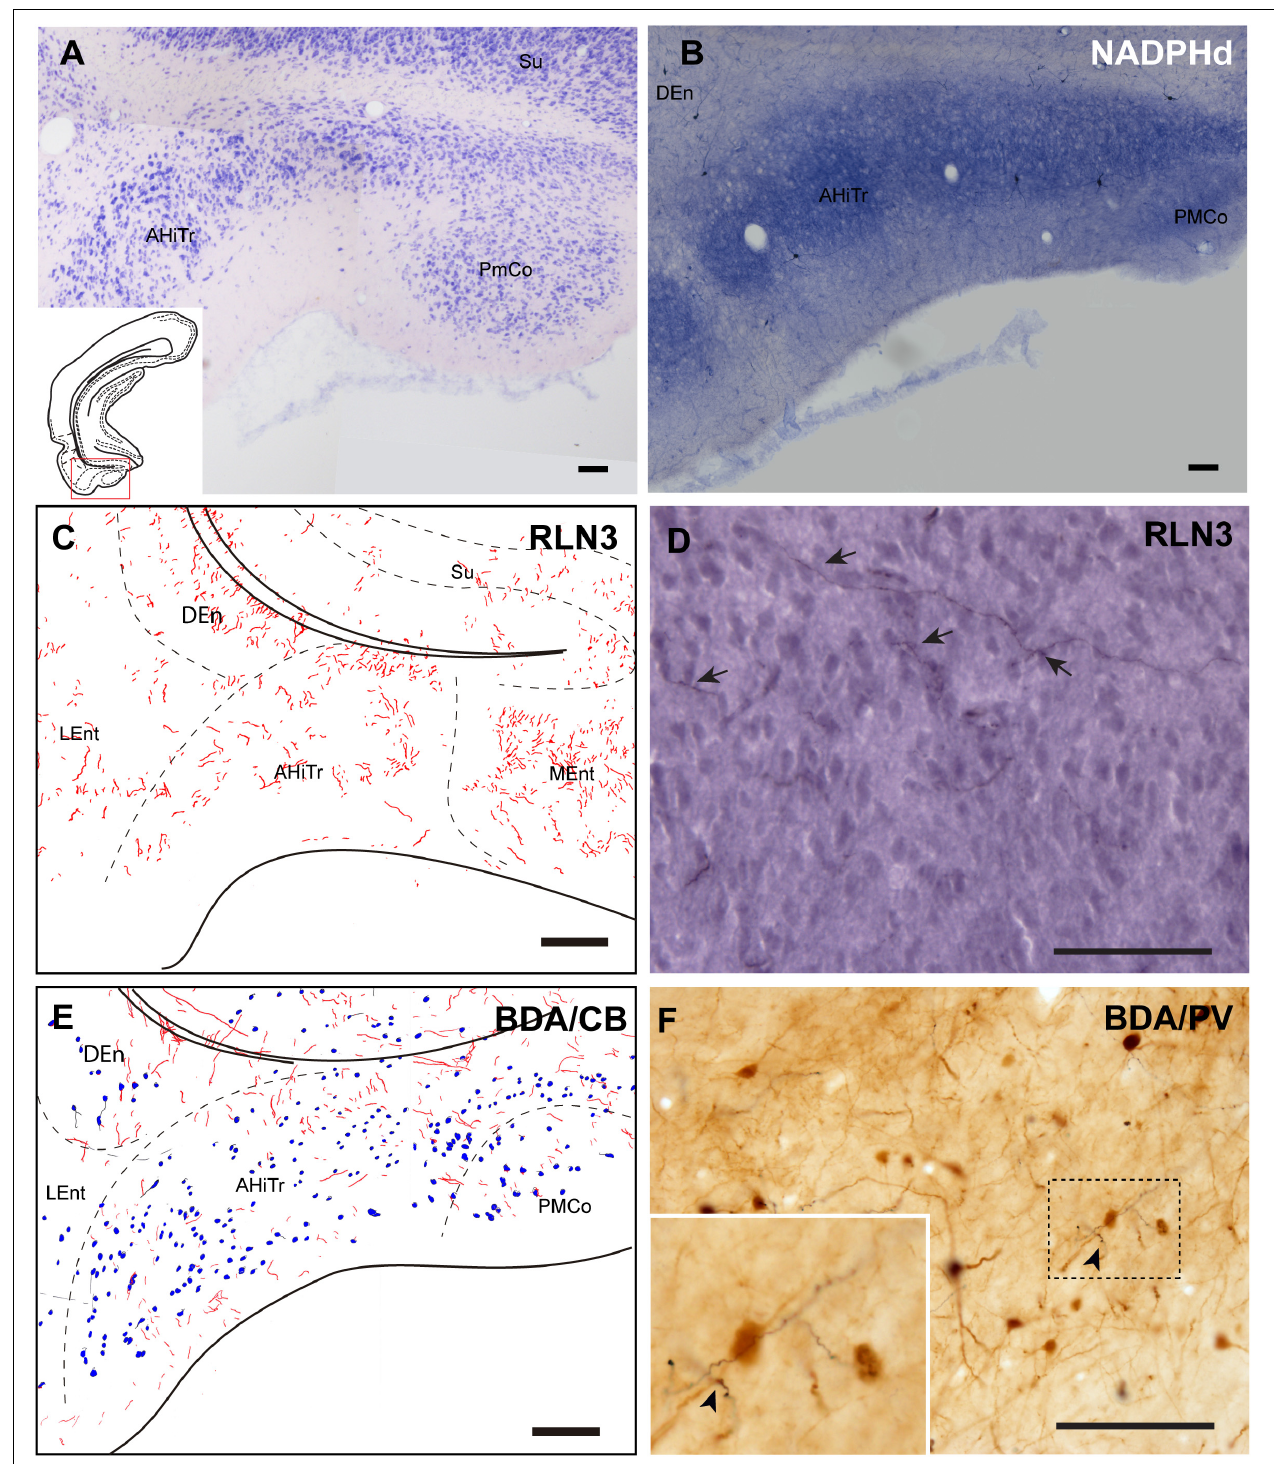
FIGURE 7 | Distribution of anterograde labeling and RLN3 staining in the amygdalohippocampal transition area and posteromedial cortical amygdala. (A) Giemsa stain. (B) NADPHd histochemistry revealed intense reaction in the amygdalohippocampal transition area and the posteromedial cortical amygdala. (C) Camera lucida drawings of RLN3 fibers in case N1. (D) Photomicrograph illustrating the appearance of labeled fibers in case N1. (E) Camera lucida drawing of sections labeled for BDA injected into the NI and for CB case FH53. (F) Photomicrograph illustrating the appearance of labeling for BDA fibers (black) and PV neurons (brown) in deep layers of the AHiTr, case FH53. Arrowhead points at close apposition between fibers and neurons. Calibration bars (A–F) 100 µ m.